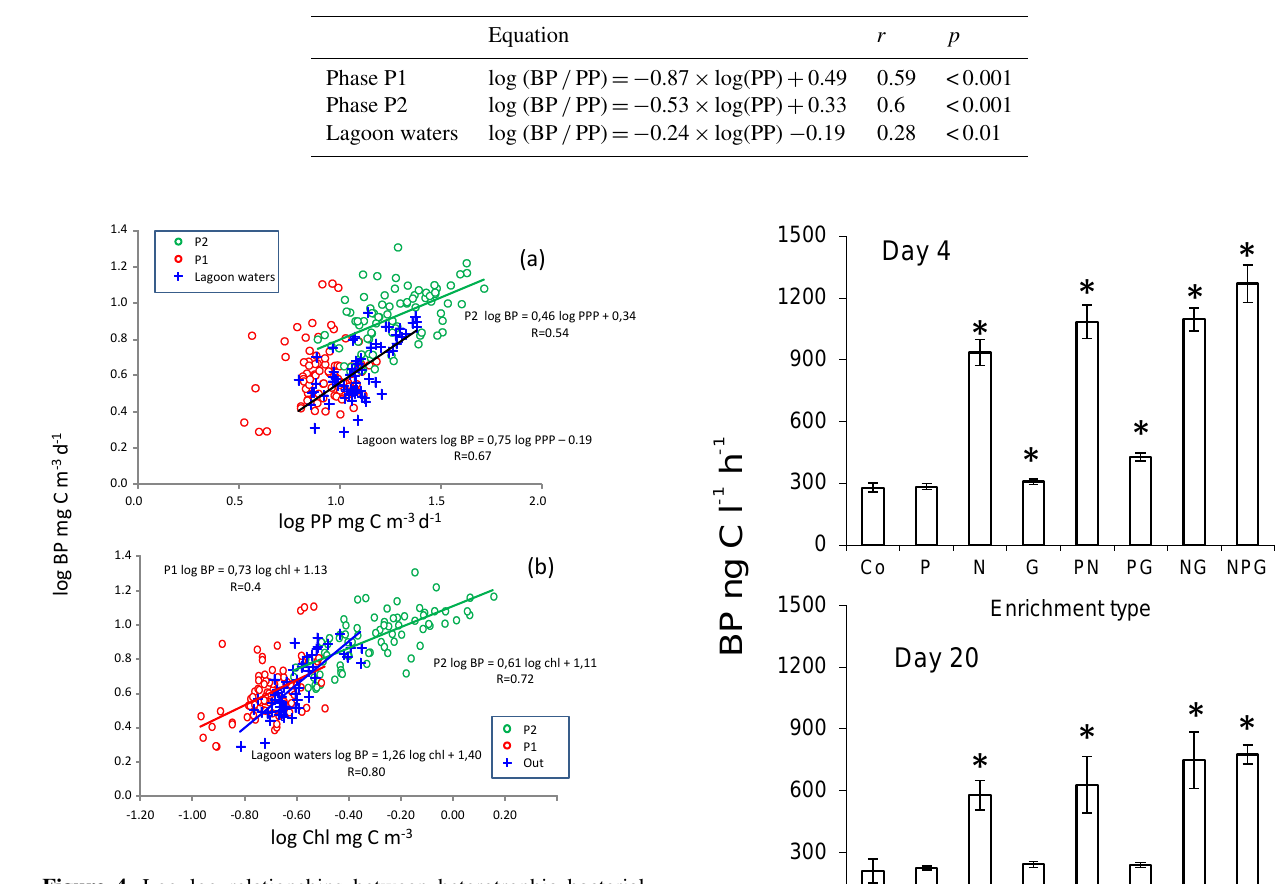
Figure 4. Log–log relationships between heterotrophic bacterial production (BP) and (a) primary production (PP) or (b) chloro- phyll a (Chl).